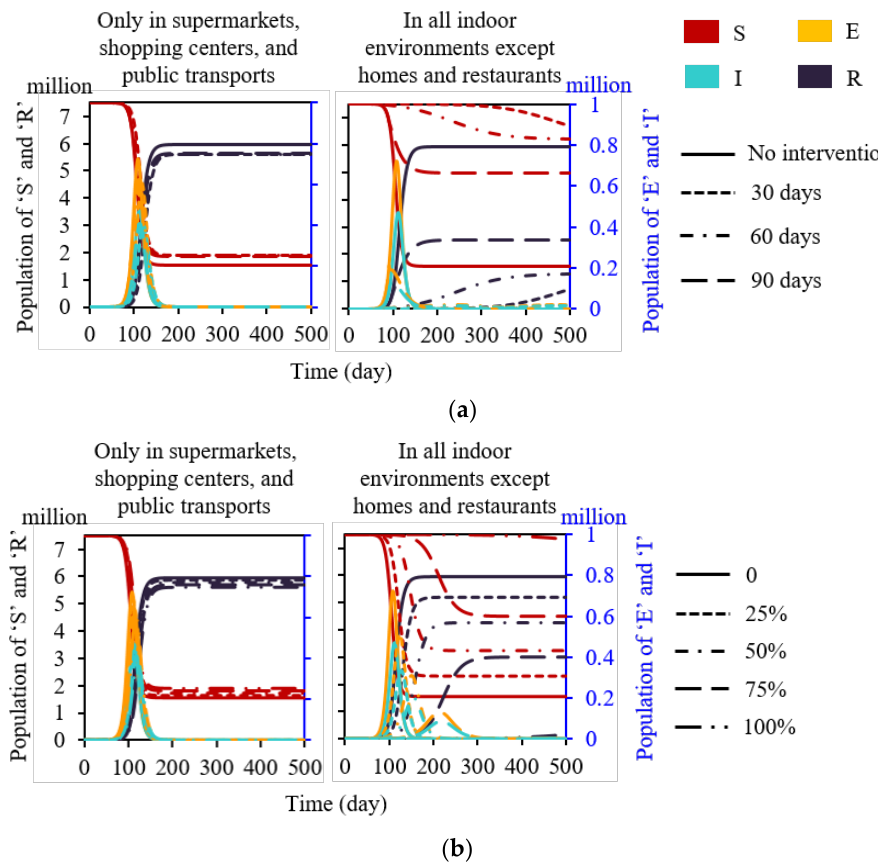
Figure 4. Efficiency of the mask-wearing in built environments under two scenarios (only in shopping centers and public transport; in all built environments except homes and restaurants). ( a ) Implementation time (proportion was assumed to be 100%). ( b ) Implementation intensity (interventions were assumed to be implemented on the 31th day after the first confirmed case).